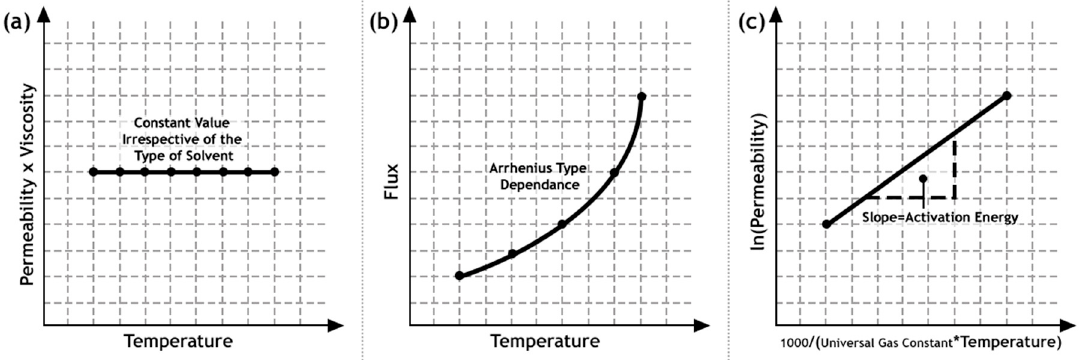
Figure 9. ( a ) The plot between the product of permeability and viscosity against temperature for various solvents depicting the validity of the viscous flow mechanism. ( b , c ) The nature of plots obtained when pervaporation is occurring in theregime described by the adsorption–diffusion model.